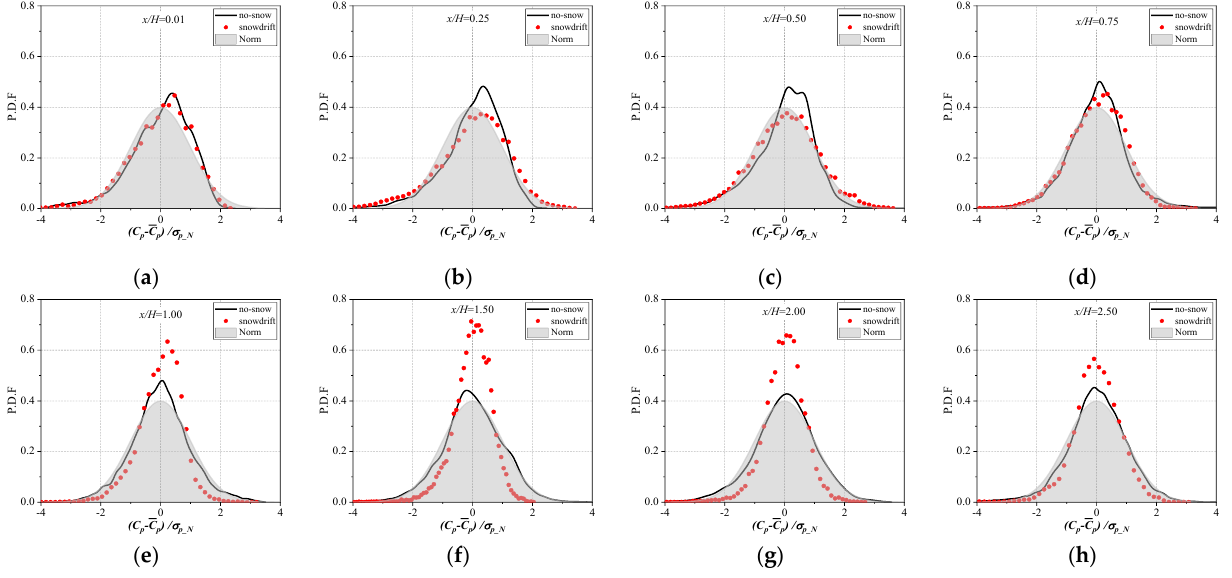
Figure 16. Probability density distribution of fluctuating wind pressure at monitoring points (( a ) x/H = 0.01; ( b ) x/H = 0.25; ( c ) x/H = 0.5; ( d ) x/H = 0.75; ( e ) x/H = 1.0; ( f ) x/H = 1.5; ( g ) x/H = 2.0; ( h ) x/H = 2.5).